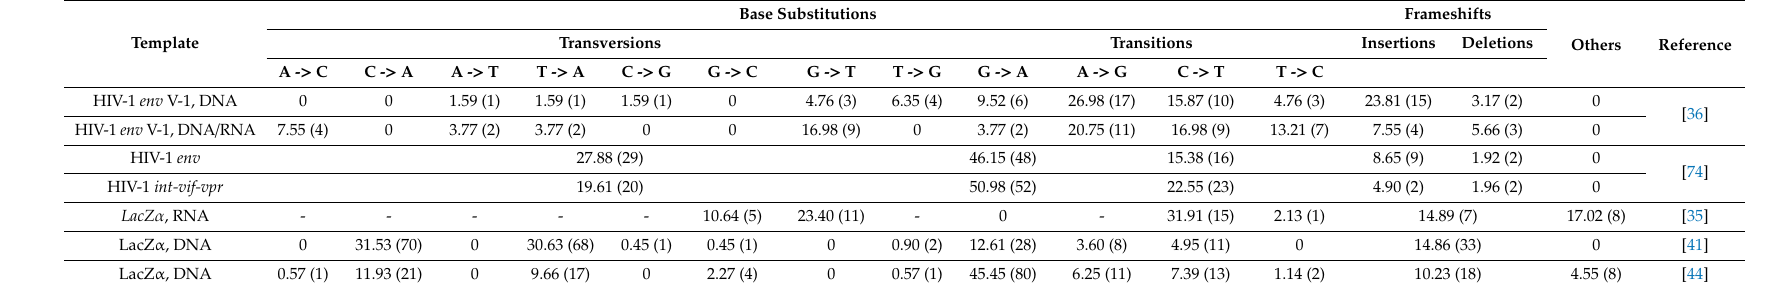
Reported percentages were calculated using previous research, with exact reported numbers indicated in